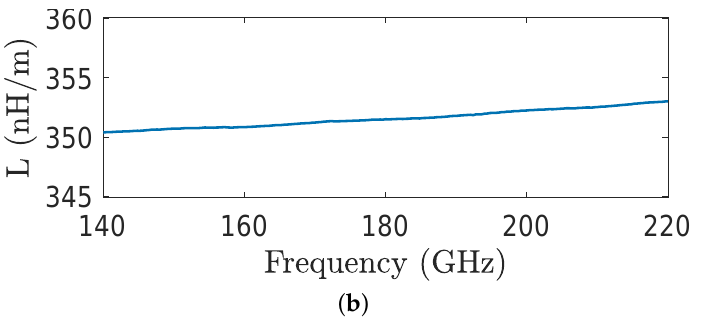
Figure 5. Frequency dependence of the extracted per-unit-length resistance R ( a ) and the extracted per-unit-length inductance L ( b ) within the frequency range from 140 to 220